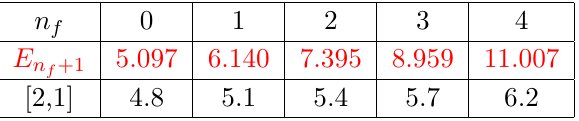
Table 2 . Comparison between the value of e F E in d = 5 (black) as a function of n